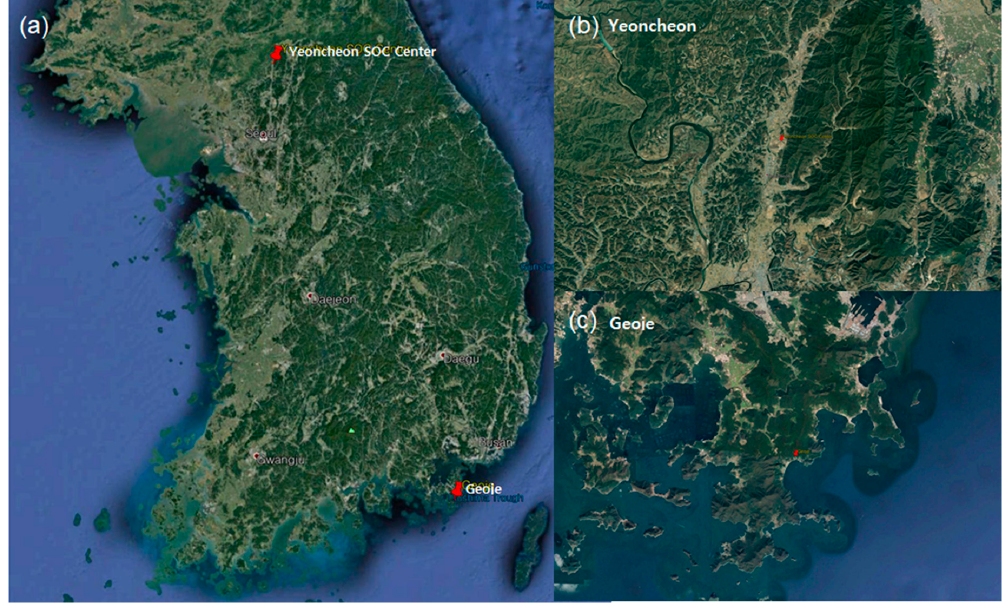
Figure 8. Configuration of the location of the two main test sites. ( a ) Sites location on South Korea map and detailed location of ( b ) Yeoncheon and ( c ) Geoje.